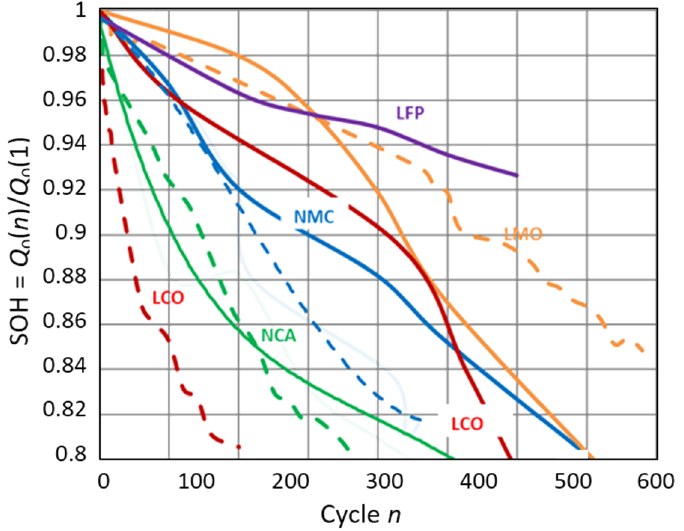
Figure 1. Cycle aging of lithium-ion batteries: Loss of available capacity. Full charge–discharge cycles (DOD 100%, solid ––). Partial discharge (DOD 20%, where n = 1 is 5 cycles, dashed - - -).